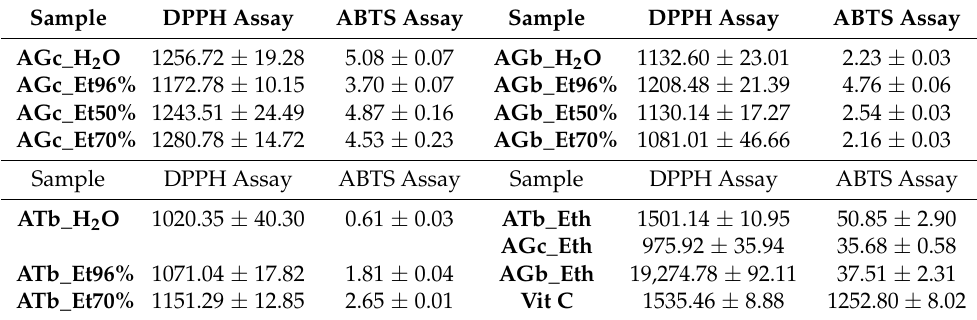
Table 6. The antioxidant activity of extracts from of Kazakhstani bulbs— Allium galanthum bulbs and chives (AGb and AGc, respectively) and Allium turkestanicum bulbs